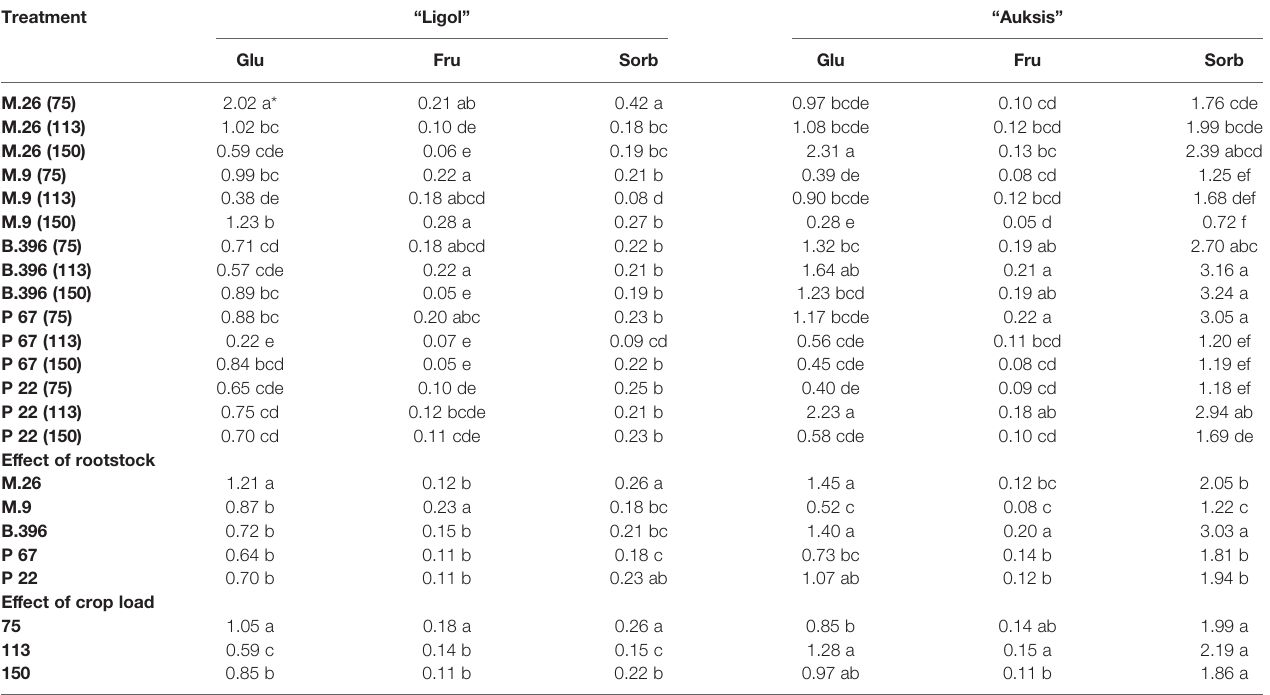
TABLE 5 | The effect of rootstock and crop load interaction on the accumulation of soluble sugars in “ Ligol ” and “ Auksis ” buds (mg g − 1 . FW).